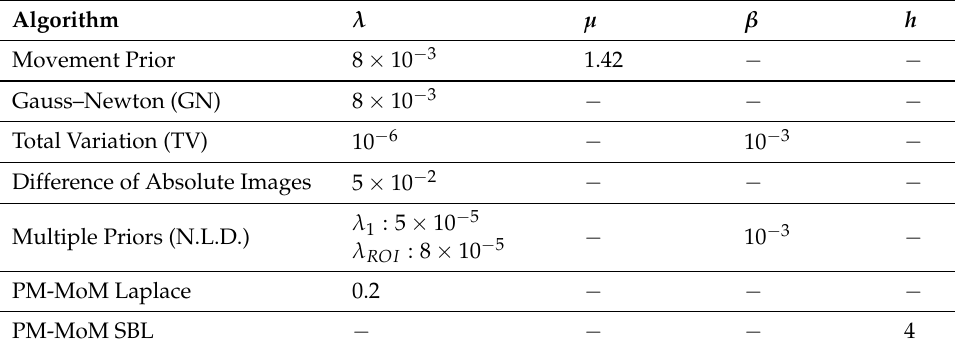
Table 3. Selection of reconstruction parameters per